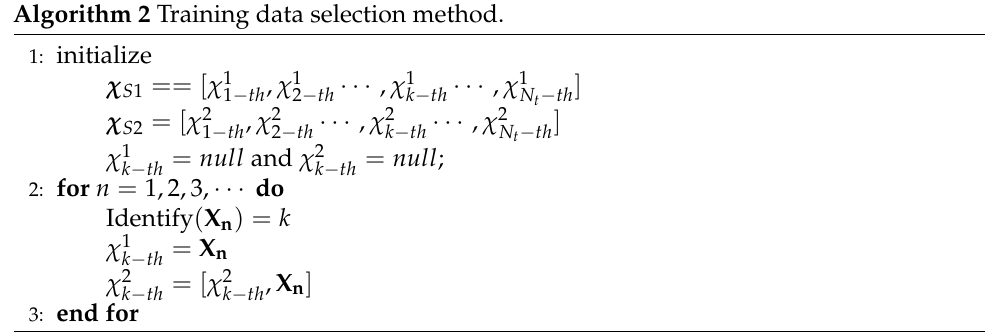
Algorithm 2 Training data selection